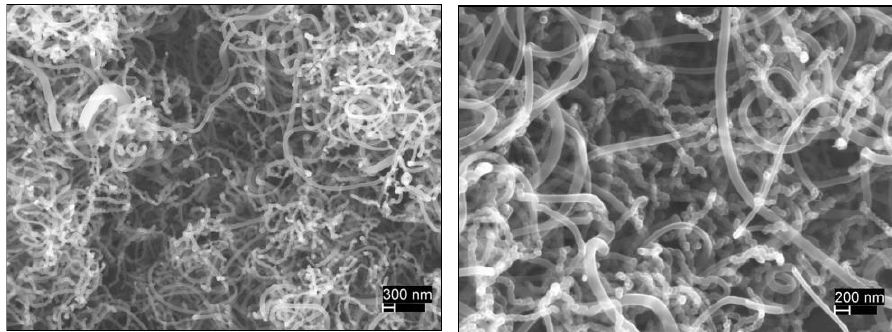
Figure 9. SEM micrograph of the foam structure at two magnifications (see scale bars). The foam consists of interwoven carbon nanofibers with diameters between 20 and 200 nm.